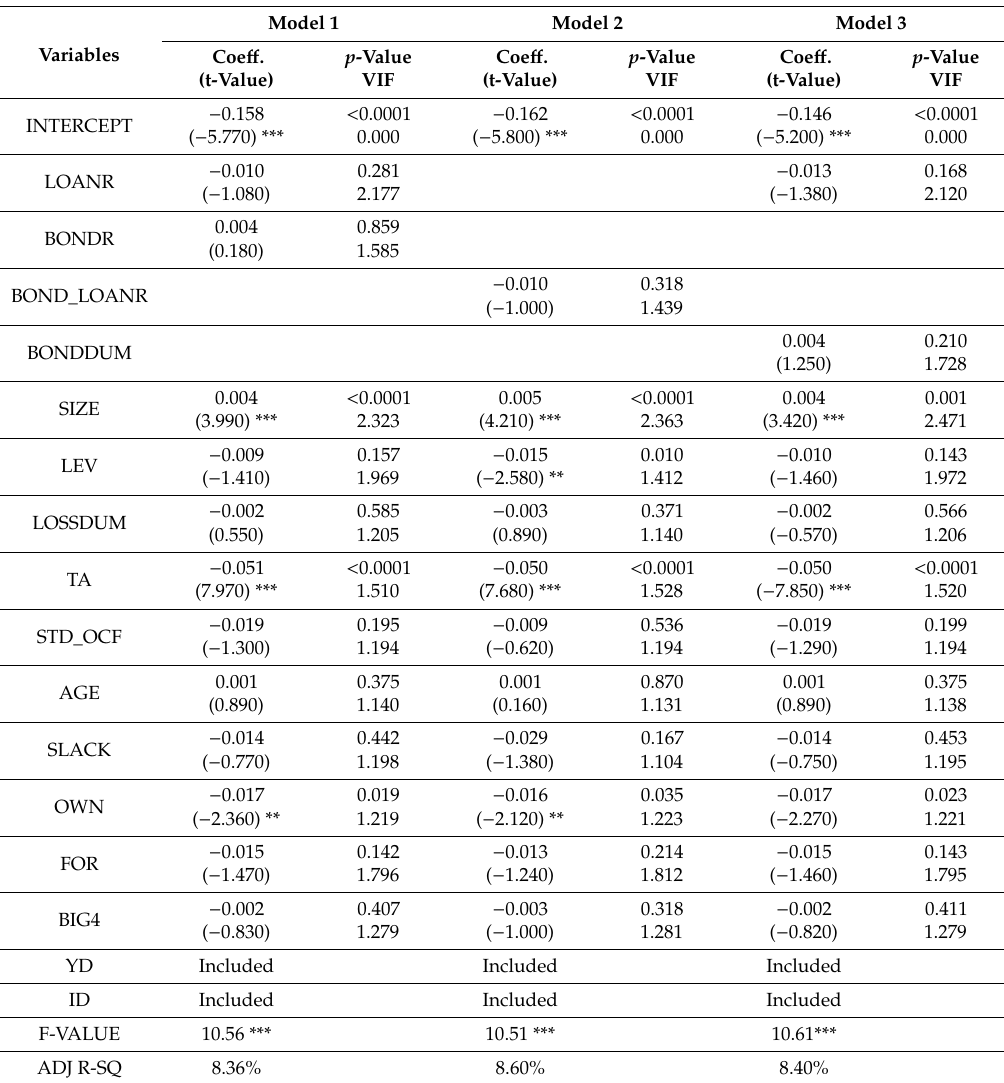
Table 6. Debt origin and investment e ffi ciency: overinvestment sample (n =